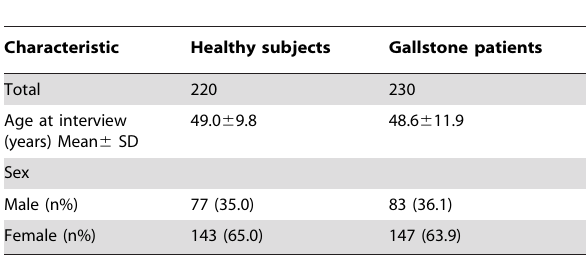
Table 1. Demographic profile of controls and gallstone